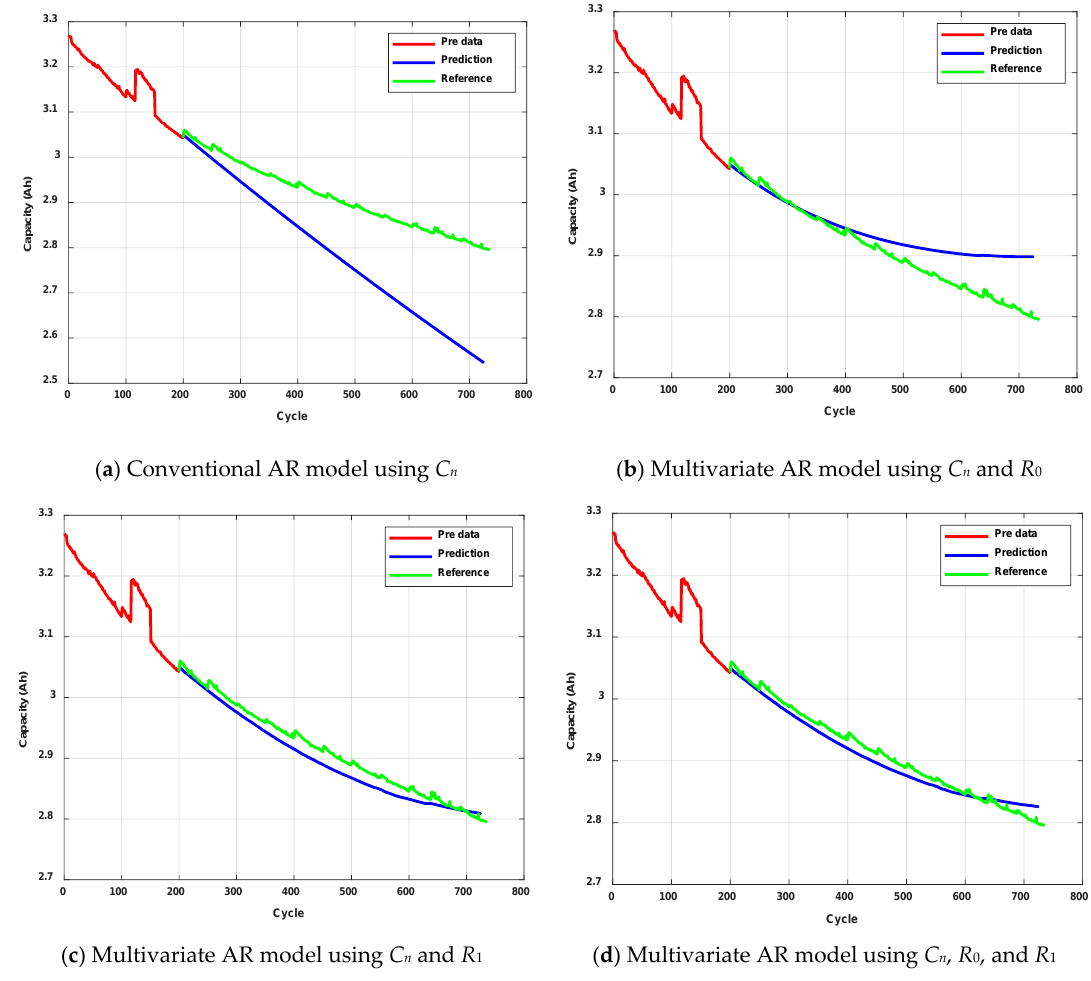
Figure 11. Capacity prediction results obtained using the autoregressive (AR) model and the measured capacity.